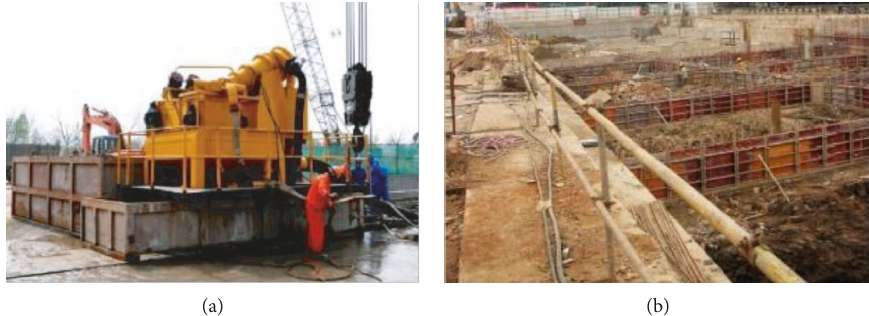
Figure 3: A schematic view of Jiangbei pit. (a) Diaphragm wall trenching. (b) Concrete struts setting.